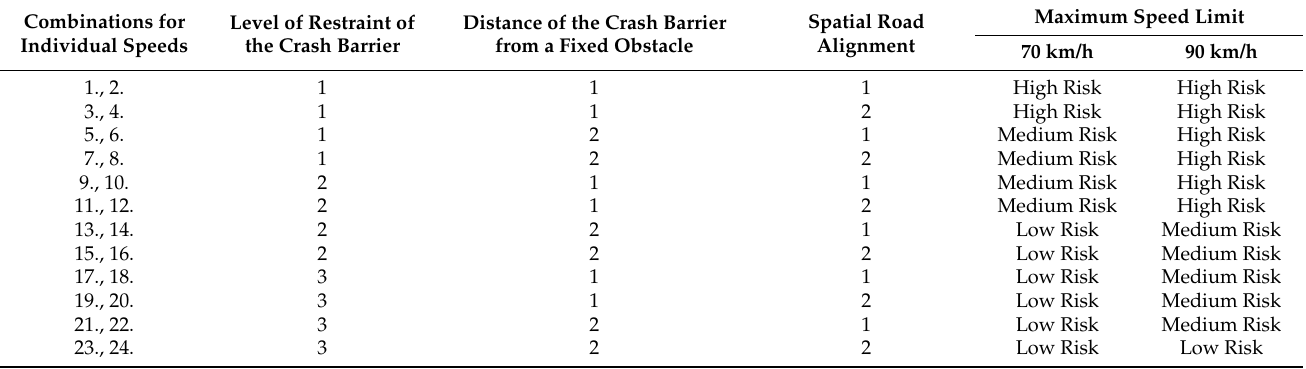
Table 6. Predicted risk level of individual exposures for defect—Insufficient minimum distance behind the crash